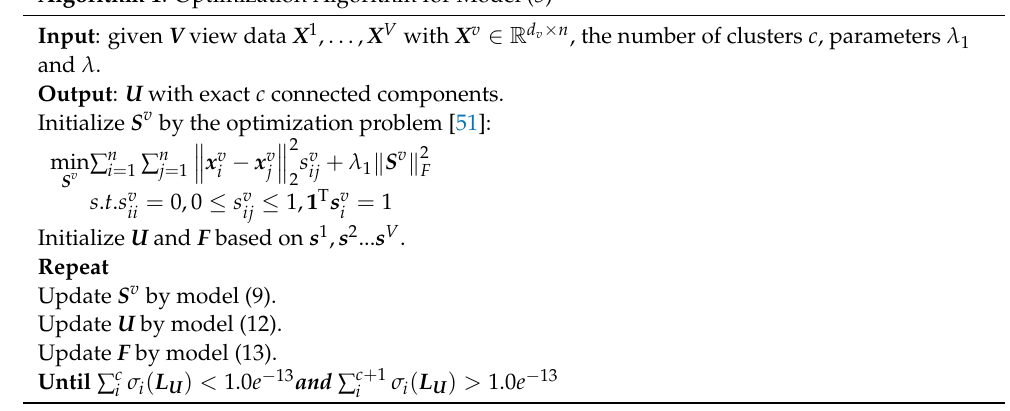
Algorithm 1 : Optimization Algorithm for Model (5)